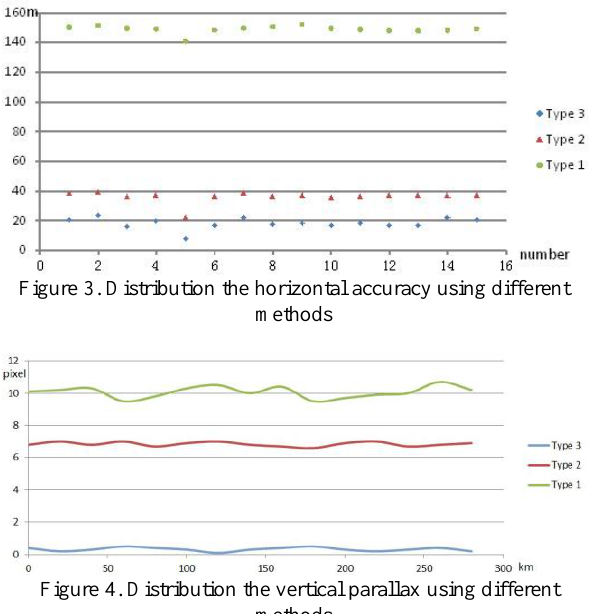
Figure 4. Distribution the vertical parallax using different